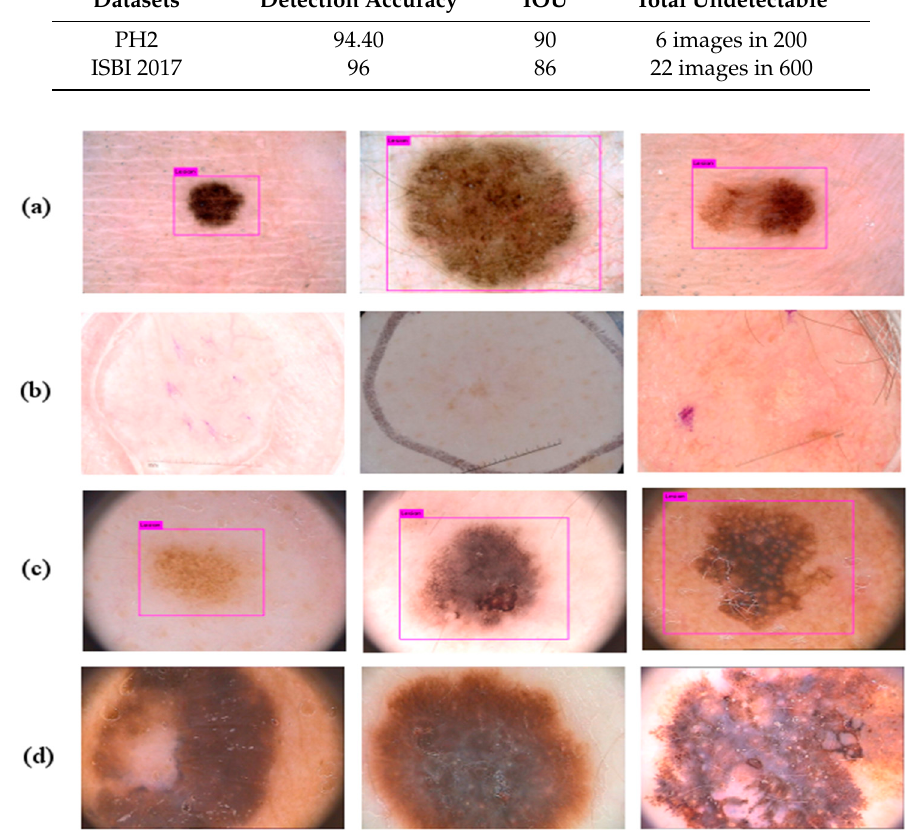
Figure 12. Results of skin lesion location detection by Yolov3 in dermoscopic images. ( a , c ) are successful detections on the ISBI 2017 and the PH2 respectively. ( b , d ) show unsuccessful detections on the ISBI 2017 and the PH2.